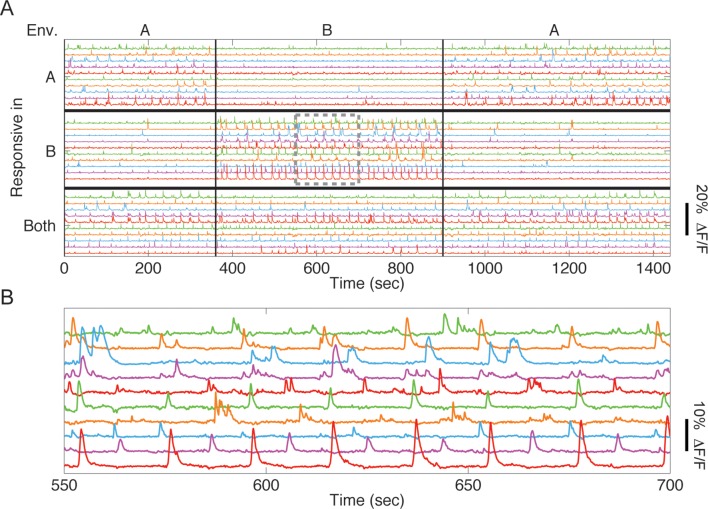
CA1 neurons exhibit selective Ca2+ responses in the two environments.(A) Example time traces of 30 cells from one mouse, taken from the same-session remapping test. We found cells that responded mostly in environment A (10 cells whose traces are depicted at the top), mostly in environment B (10 cells whose traces are depicted at the middle), or in both environments (10 cells depicted at the bottom). (B) Inset of boxed area in A.